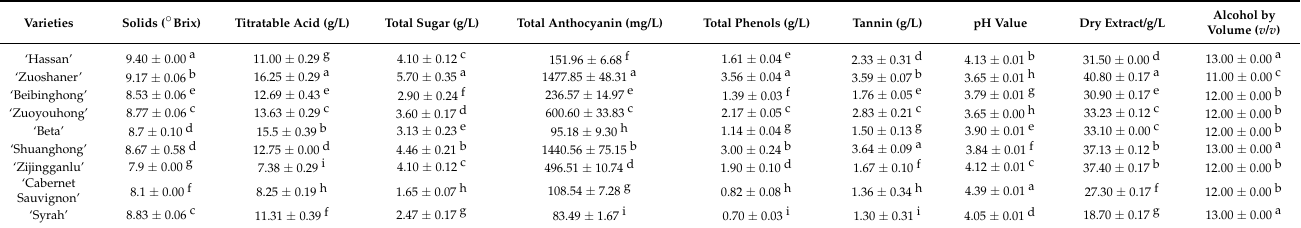
Table 3. The basic physical and chemical indicators of the original wine.